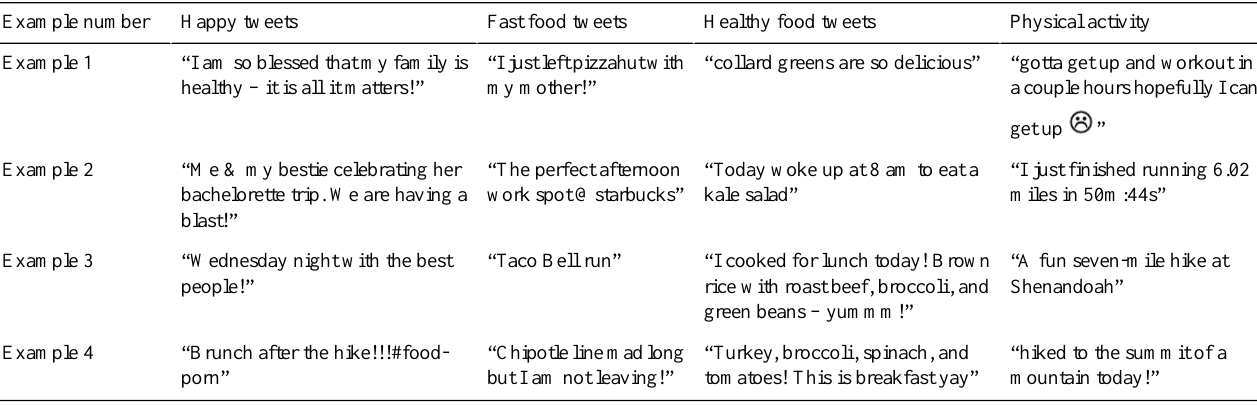
Table 3. Examples of each Twitter characteristic a